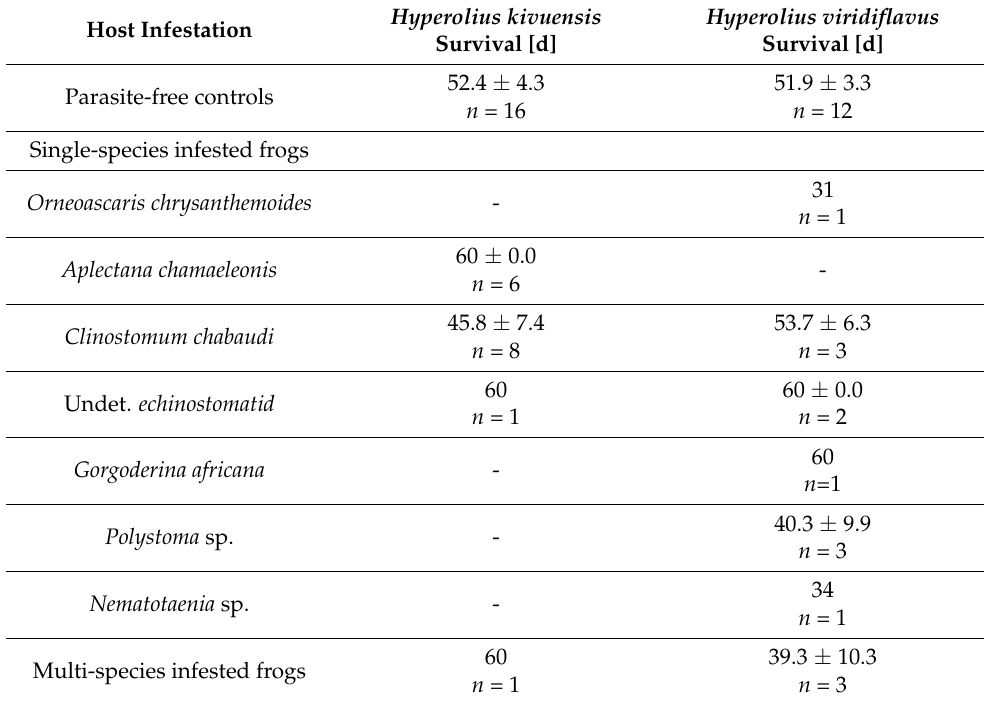
Table 5. Effect of host infestation on survival of frogs collected in the wild and kept 60 d in